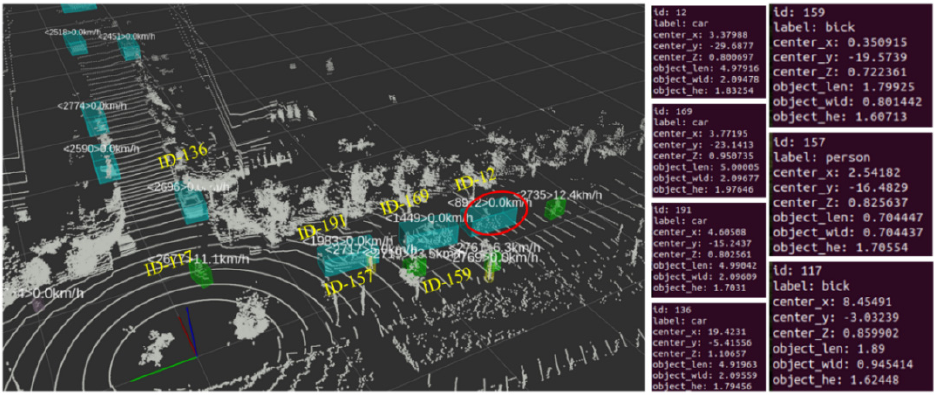
Figure 12. Visualized output of roadside platform perception results.